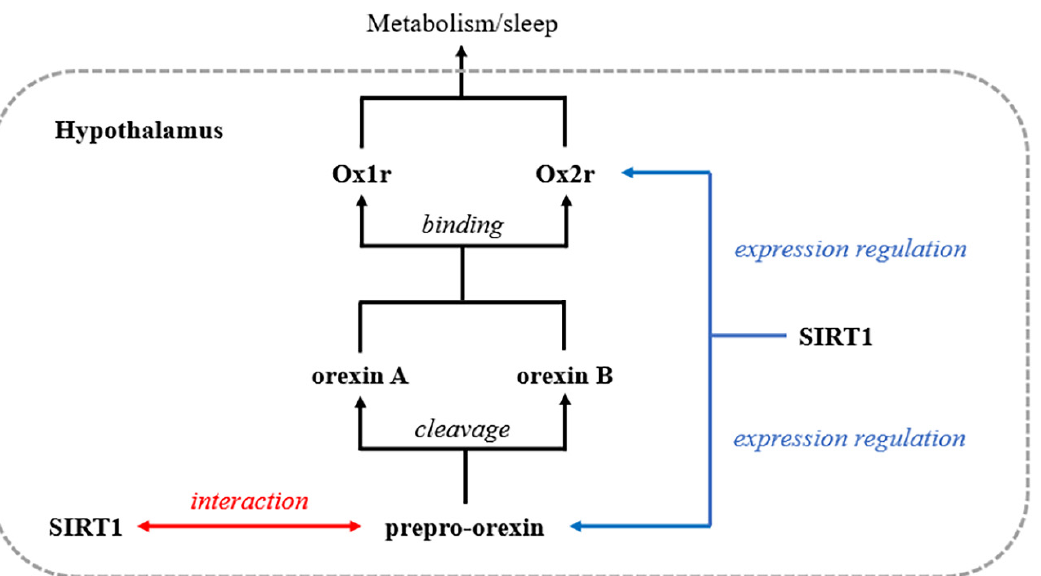
Figure 4. Relationship between SIRT1 and orexins in the normal physiological and pathological environment of ALS (SOD1G93A mice). SIRT1: Silent mating type information regulation 2 homolog 1; Ox1r: Orexin type 1 receptor; Ox2r: Ox1r: Orexin type 2 receptor; Black line: the way of orexins produces biological functions; Blue line: association between orexins and SIRT1 under normal physiological environment; Red line: additional association between orexins and SIRT1 in the ALS pathological environment (SOD1G93A mice).